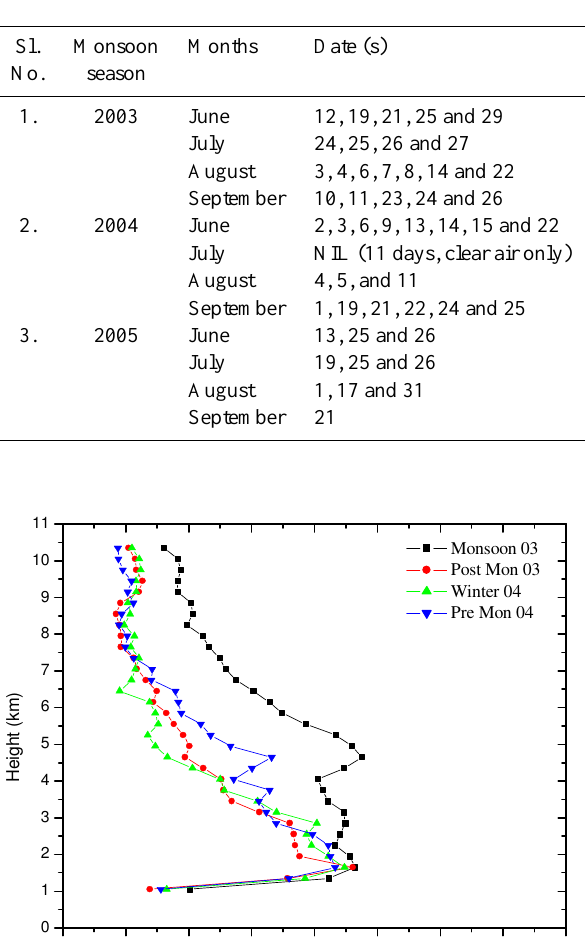
Table 2. Precipitation days, excluded in studying the turbulence parameters.